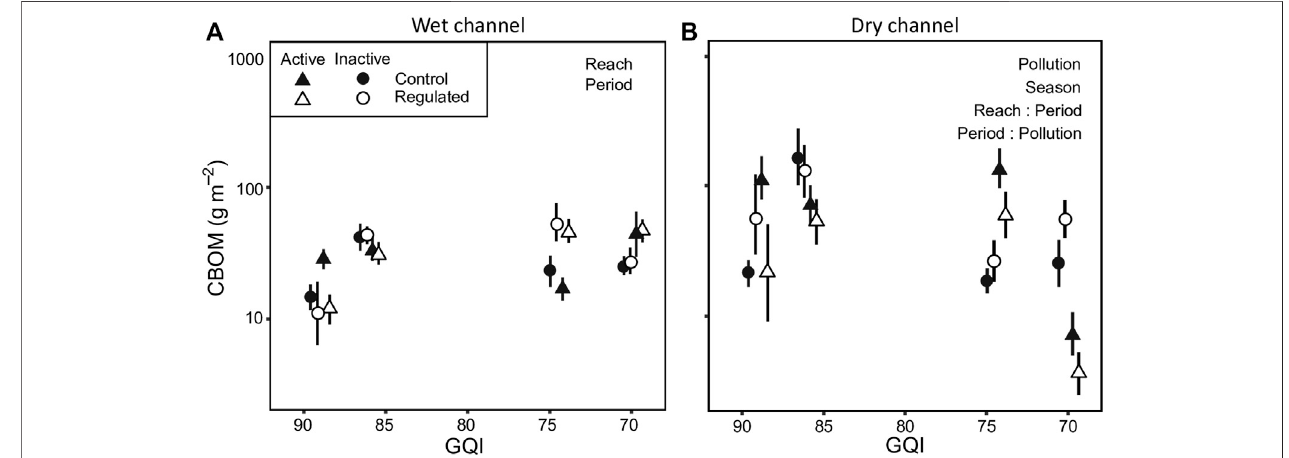
FIGURE 2 | Stock of coarse benthic organic matter (CBOM) in (A) wet and (B) dry channel. Values are means and error bars show standard errors. The text in the background indicates signi fi cant single-factor effects or interactions. GQI is the General Quality Index and the scale is inverted to make easier the interpretation of the fi gure, ranging from good (low pollution) to acceptable quality level (moderate pollution). GQI values have been jittered to avoid overlapping points.